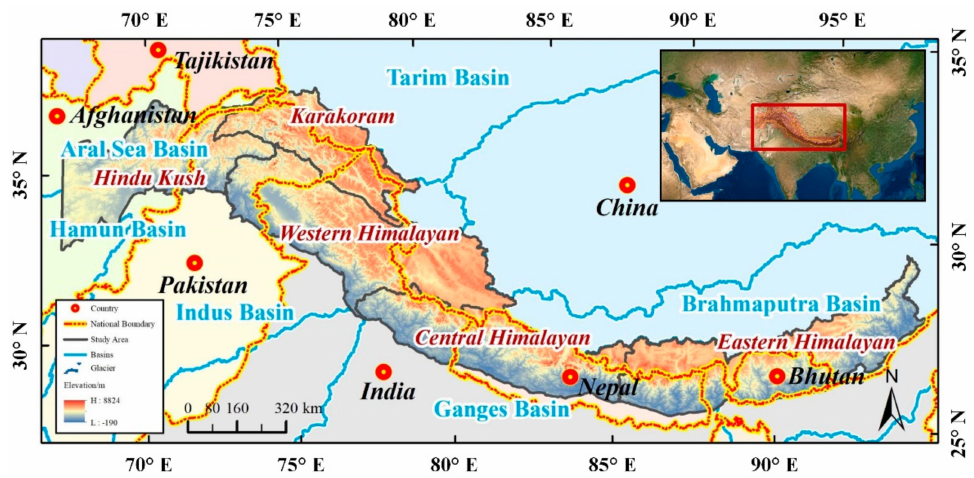
Figure 1. The geographic location of the HKH-TMHA